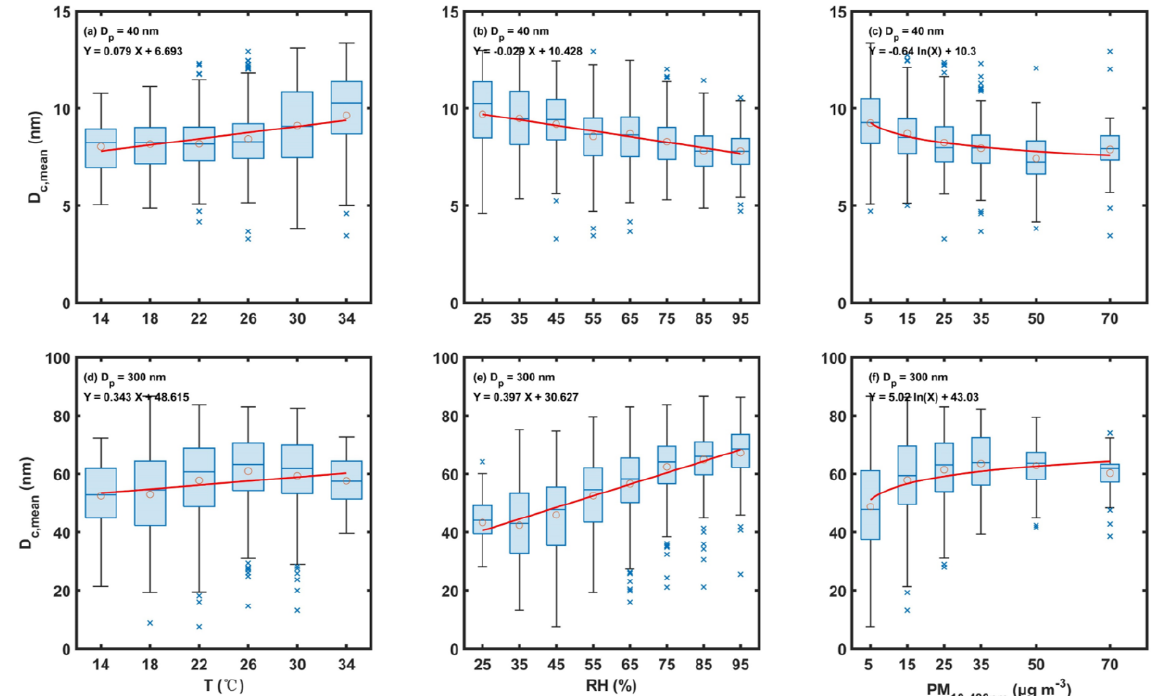
Figure 10. Relationships between ensemble mean coating depth ( D c , mean ) and ambient T (a, d) and RH (b, e) and PM 10 − 400nm (c, f) for 40 (a, b, c) and 30nm (d, e, f) particles. The circles show the mean D c , mean , with boxes showing the 25th, 50th, and 75th percentiles and extremities showing the 5th and 95th percentiles. Red lines show the linear or logarithmic fitting lines through the data, and best-fit relations are given in each